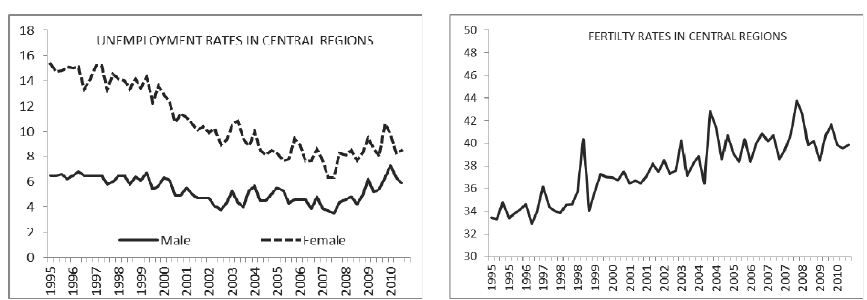
Figures 5, 6 – Unemployment and fertility rates in Central regions.